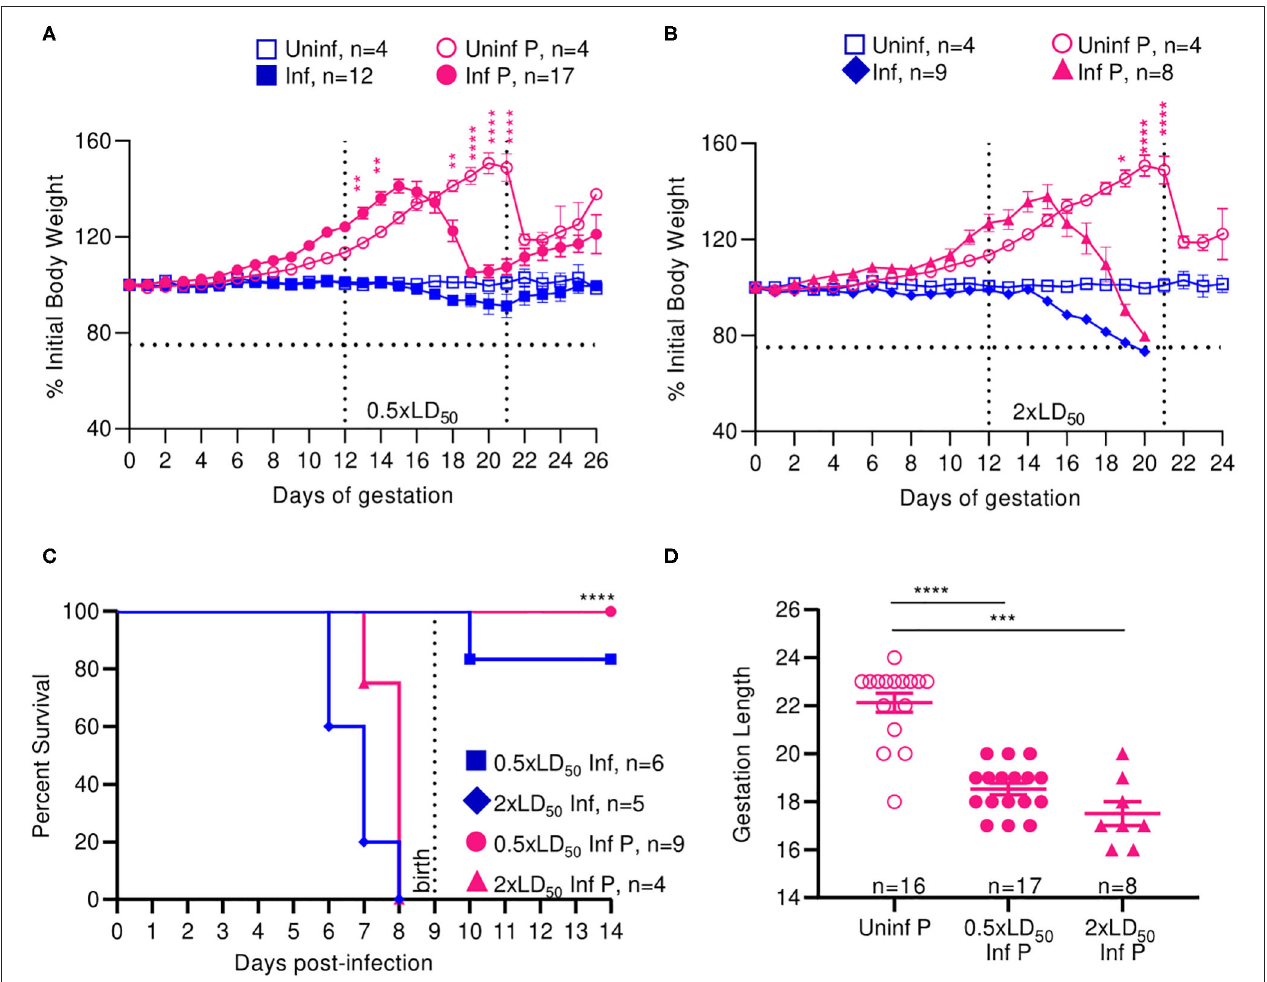
FIGURE 1 | Infection with A/California/07/2009 attenuates maternal weight gain and reduces gestation length. Body weight changes across gestation were tracked and weight changes relative to weight at day 0 are plotted. Pregnant and non-pregnant mice were infected with either (A) 0.5- or (B) 2xLD50 of A/California/07/2009. Animals were infected at E12, denoted by the left-most vertical line. The horizontal line denotes the terminal weight endpoint. The right-most vertical line denotes expected delivery day following uncomplicated pregnancy (C) Percent survival curves comparing pregnant and non-pregnant animals infected with either 0.5- or 2xLD50. (D) Gestation length following infection with either 0.5- or 2xLD50. Each data point represents a single dam’s delivery date. Error bars represent Standard Error of Mean (SEM) for all graphs. Weights were analyzed using Two-way ANOVA with Tukey post-host corrections. Survival data was analyzed using Mantel-Cox test and gestation length data was analyzed using a Kruskal-Wallis test with a Dunn’s post-hoc test for multiple comparisons. * p < 0.05; ** p < 0.01; *** p < 0.001; **** p < 0.0001.